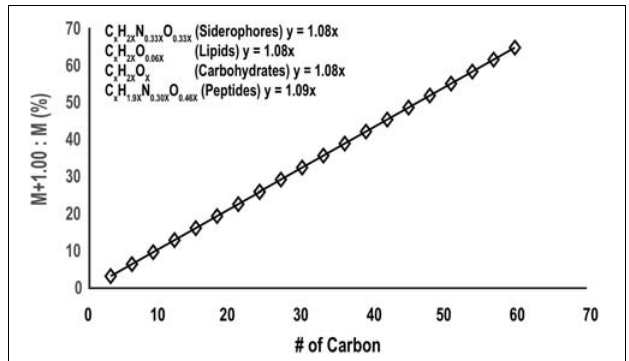
FIGURE 8 | The relative abundance of the 13 C: 12 C isotopologue molecular ions (M+1.00/M) as a function of carbon number for siderophores, lipids, carbohydrates, and proteins (the molecular formula is extracted from Rivas-Ubach et al., 2018). Although these classes of metabolites are different in the ratio of H, N, and O they incorporate relative to C, the change in carbon isotopic ratio with carbon number between them is very small and for the mass search algorithms the ratio can be approximated by the slope of the plot